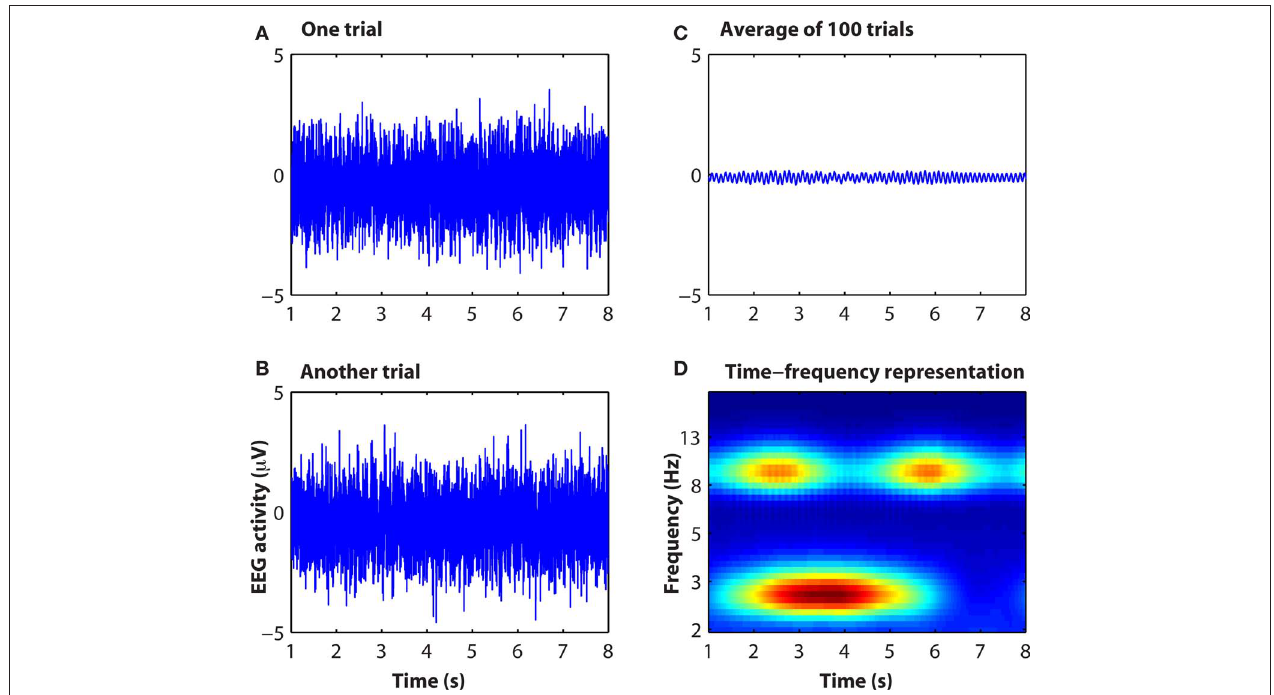
Figure 3 | Simulated data showing how information contained in raw eeg data [ (A,B) : single “trials”] is not apparent in the event-related potential (C) but is readily observable in the time–frequency representation (D) . Matlab code to run this simulation is available from the